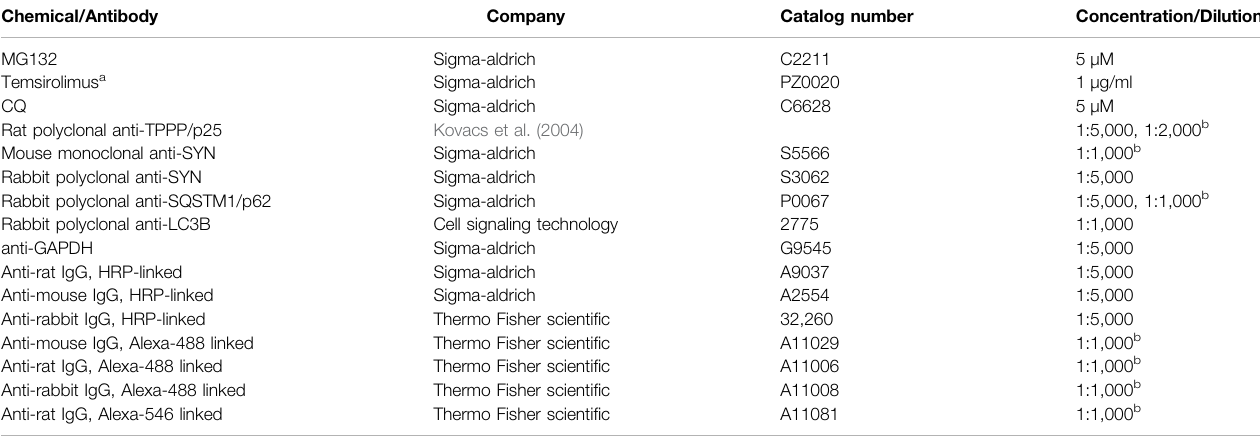
TABLE 1 | Key chemicals and antibodies used in the